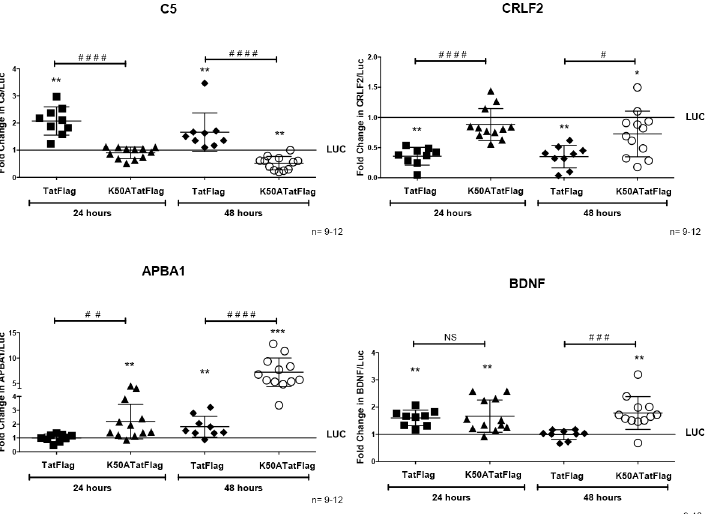
Fig 6. Lysine 50 of Tat regulates expression of C5, CRLF2, APBA1, and BDNF genes. THP-1Tat-Flag and THP-1Tat K50ATat-Flag cell lines (generatedfrom independentexperiments describedin Fig 5) were differentiated to macrophages with PMA for 24 and 48 hours. Total RNA was extracted, and cDNA was generated.Quantificationis expressedin arbitrary units, relative to THP-1-luciferase set to 1, and target mRNA levels were normalized to 18S expressionusing the method of Pfaffl. The K50ATat-Flag mutant decreased Tat-Flag complex mediatedC5 expression, and its expressionis similar to the control at 24 hours. For CRLF2, this mutant had a similar effect on gene expressionas the control. K50ATat-Flag mediateda very significantincreasein gene expressionof APBA1 at both time points in comparisonto wild type Tat-Flag complex and the control. For BDNF, K50ATat-Flag had the same effect on geneexpressionas did wild type Tat-Flag at 24 hours, and increasedBDNF expression at 48 hours, in comparisonto Tat-Flag and the control. Significance ( * ) betweencontrol (Luc) and Tat-Flag was determinedusing a Wilcoxon signed-rank.Error represents the median ± S.D.; * P < 0.05, ** P < 0.01, *** P < 0.001. For comparisonbetweenTat-Flag and K50ATat-Flag (#) gene expression, Mann-Whitney tests were performed. Error represents the median ± S.D.; # P < 0.05, ## P < 0.01, ### P < 0.001, #### P < 0.0001, NS: not significant.